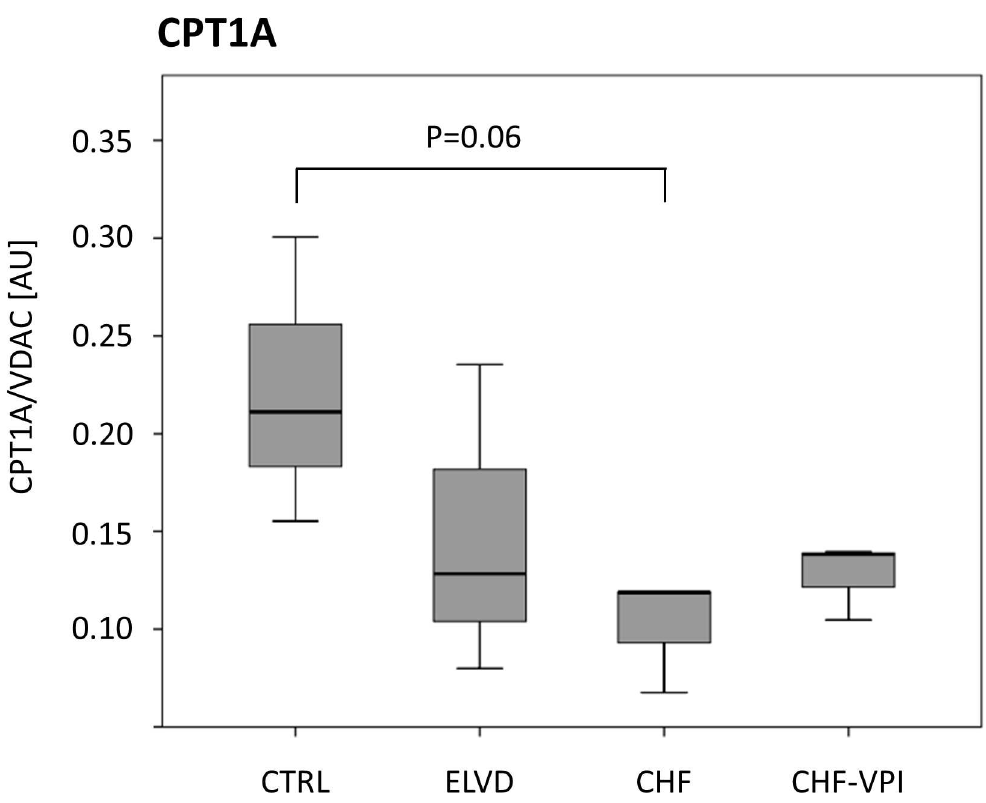
Fig 3. Protein expression level of carnitine palmitoyltransferase1 A normalized to the expressionof the outer mitochondrial membrane protein VDAC.